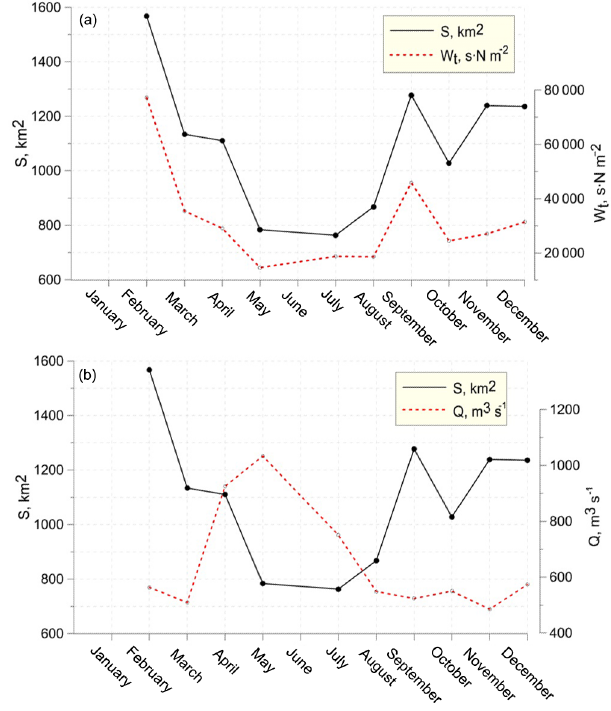
Figure 9. Dependence between (a) monthly averages of wind forc- ing index W t and (b) total discharge rate of the Don and Kuban rivers Q on the one hand, and monthly averages of the area of the AP detected at optical satellite imagery, on the other